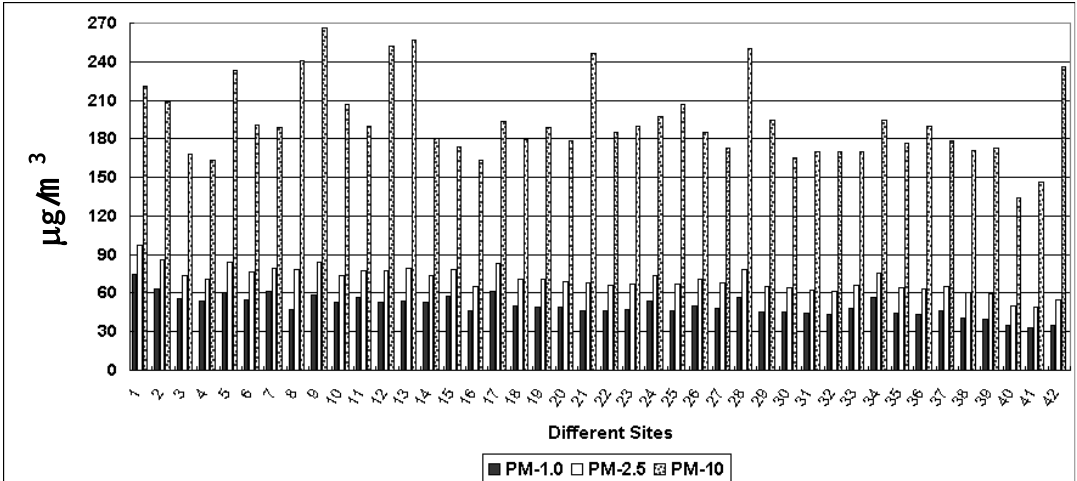
Figure 5. The distribution of mean concentration of PM 1.0 in the selected region (warm season).